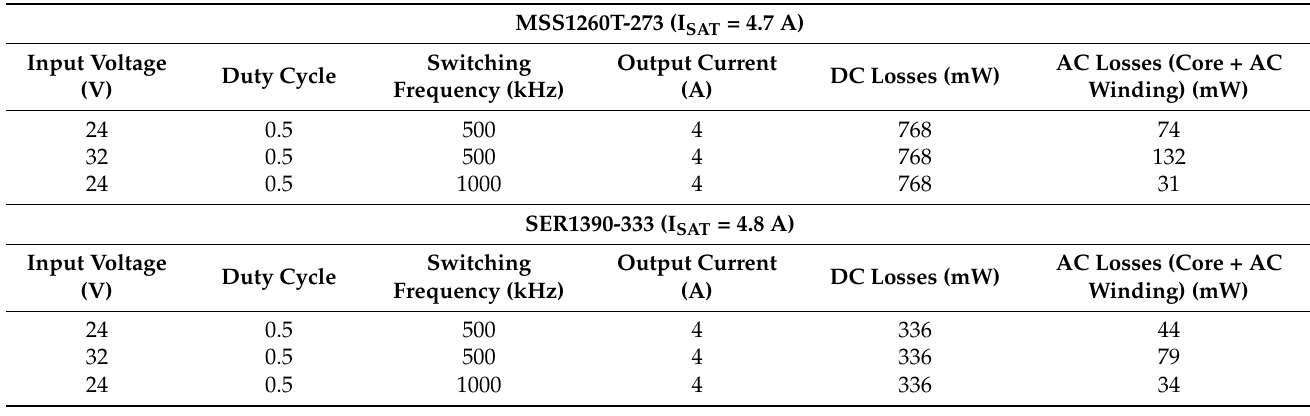
Table 1. Declared losses for two Coilcraft inductor (MSS1260T-273 and SER1390-333) under different operating conditions [16,17].